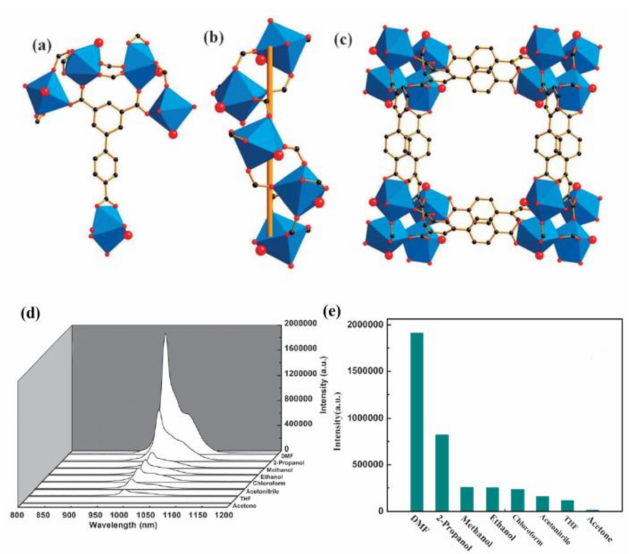
Figure 7. Crystal structure of YbMOF indicating ( a ) the BPT tricarboxylate linker and coordination environments of all Yb atoms related by symmetry; ( b ) 1D helical rod [Yb(CO 2 ) 3 ] n as the infinite SBU; and ( c ) 1D micropore of about 7.2 × 7.2 Å along c axis (Yb, blue polyhedra; C, black; O, red: terminal water molecules, large red sphere); ( d ) the PL spectra; and ( e ) the 2 F 5/2 – 2 F 7/2 transition intensities of YbMOF introduced into various pure solvent emulsions when excited at 304 nm. Reprinted with permission from [94]. Copyright 2011 The Royal Society of